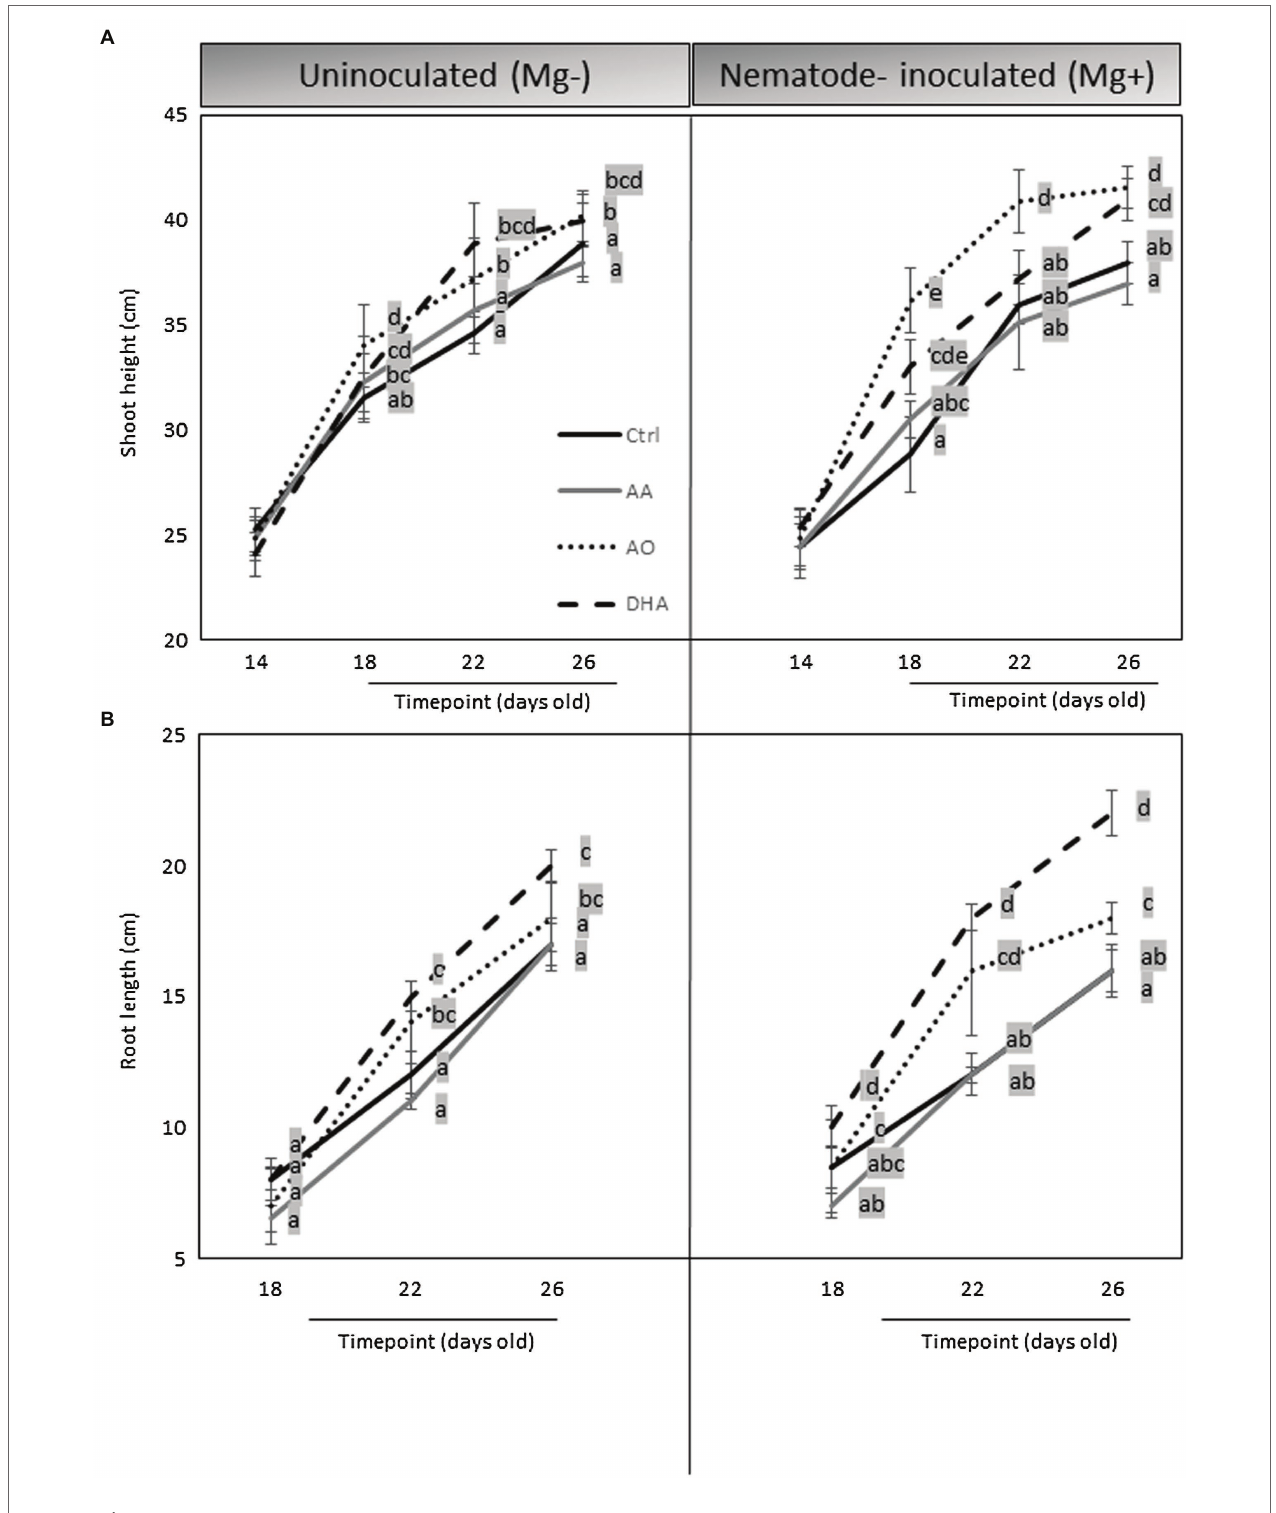
FIGURE 3 | AO/DHA enhances root growth and induces tolerance to nematode stress. Effect of AA, AO/DHA on Nipponbare (A) shoots (B) root at three time points under uninfected and nematode-infected conditions. Fourteen-days-old rice plants were first measured for their shoot height and then foliar sprayed with AA, AO/DHA, and water as a negative control (Ctrl). One day later, a subset of the plants was inoculated with 250 nematodes per plant (Mg + ) while a subset was mock inoculated (Mg − ). Shoots and roots were measured at 18, 22, and 26 days. Data were analyzed by one-way ANOVA followed by Tukey’s post-hoc test. Different letters indicate statistically different means at each time point, p ≤